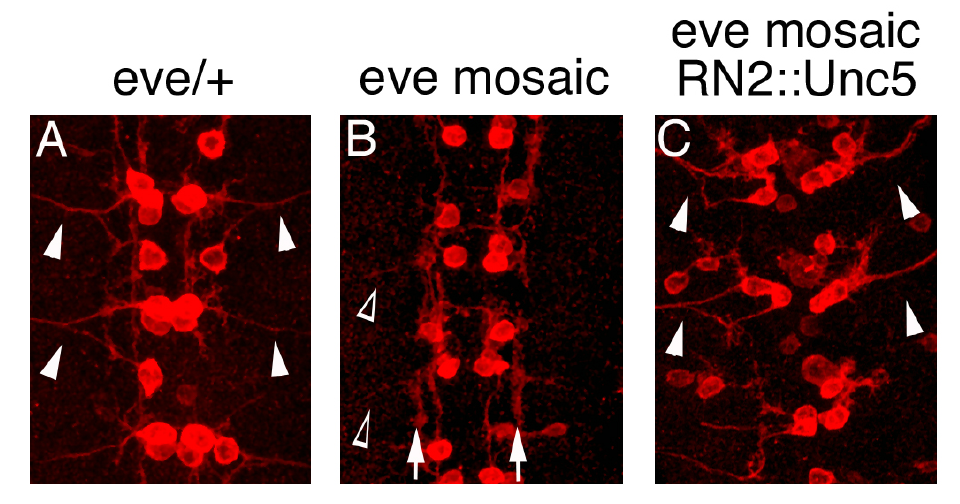
Figure 6. Eve is required for motor axon exit in Drosophila and expression of Unc-5 in eve mosaic mutants restores motor axon exit defects. ( A – C ) Stage-16 RN2Gal4::CD8GFP embryos of various genotypes, including eve /+ ( A ), mosaic eve mutant ( B ), and Unc-5 -expressing mosaic eve mutant siblings ( RN2Gal4, UAS-HAUnc-5 ) ( C ) were labeled with anti-GFP to visualize axons of somatic MNs, aCC and RP2. In eve/+ embryos, aCC and RP2 MNs extend wild type axonal projections to peripheral muscle fields (white arrowheads) ( A ). In contrast, the majority of aCC and RP2 motor axons fail to leave the CNS (89%, n = 80 hemisegments) and instead, inappropriately extend their axons longitudinally within the CNS (white arrows) ( B ). However, a small subset of motor axons does manage to exit the CNS (open white arrowhead). Notably, expression of Unc-5 in eve mosaic mutants partially rescues the aberrant motor axon exit phenotype (60% hemisegments, n = 100, white arrowheads) ( C ). In all panels, anterior is at the top of the micrograph